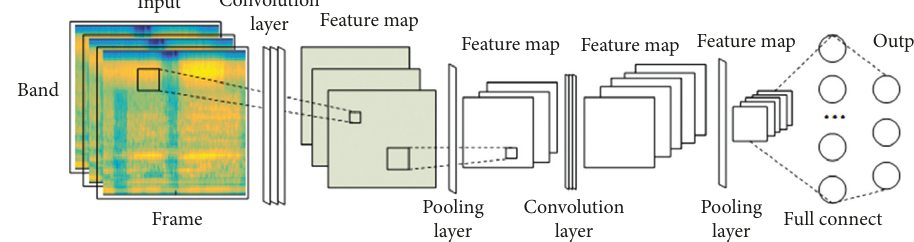
Figure 4: Structure of convolutional neural